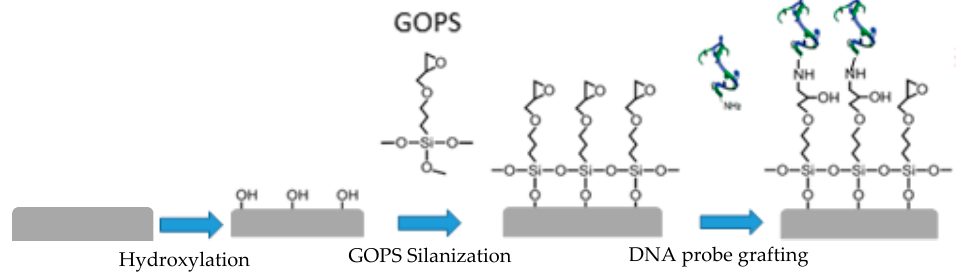
Figure A2. GOPS-based functionalization protocol for covalent DNA probe grafting.